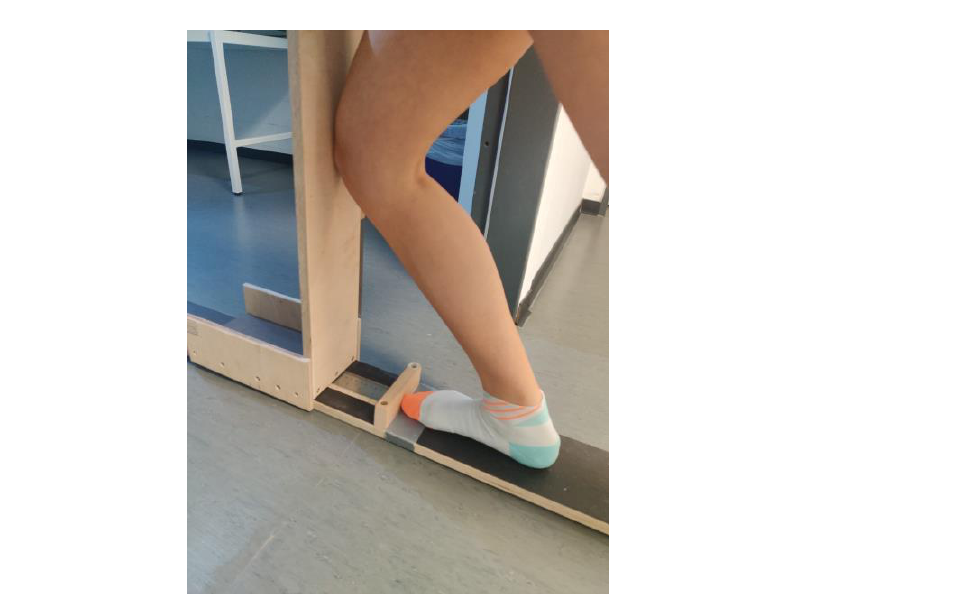
Figure 1. Using the knee-to-wall test to measure the range of motion in the upper ankle joint.